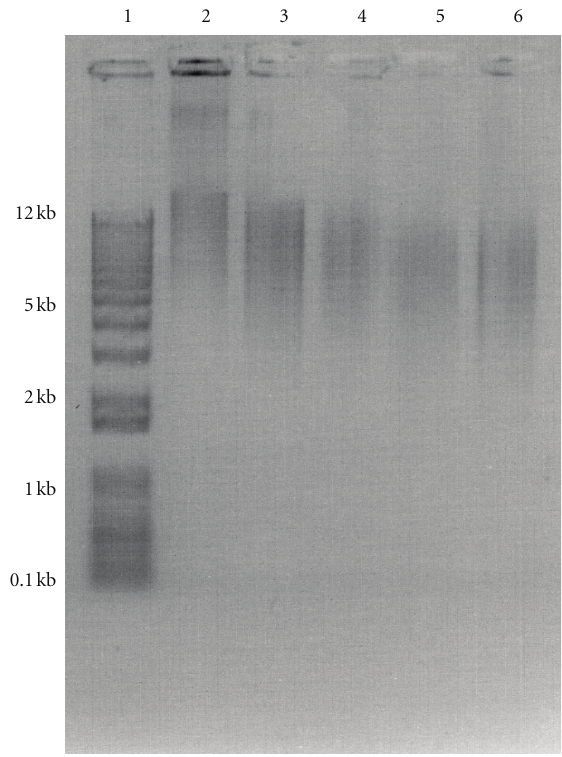
Figure 3: Representative agarose gel used in densitometric analysis of DNA recovery from spores irradiated with varying doses of EB radiation: lane 1, 1kB Plus DNA Ladder; lane 2, nonirradiated spore DNA; lane 3, DNA from spores irradiated with 5.3 kGy; lane 4, DNA from spores irradiated with 10.4 kGy; lane 5, DNA from spores irradiated with 16.0 kGy; lane 6, DNA from spores irradiated with 21.7kGy.